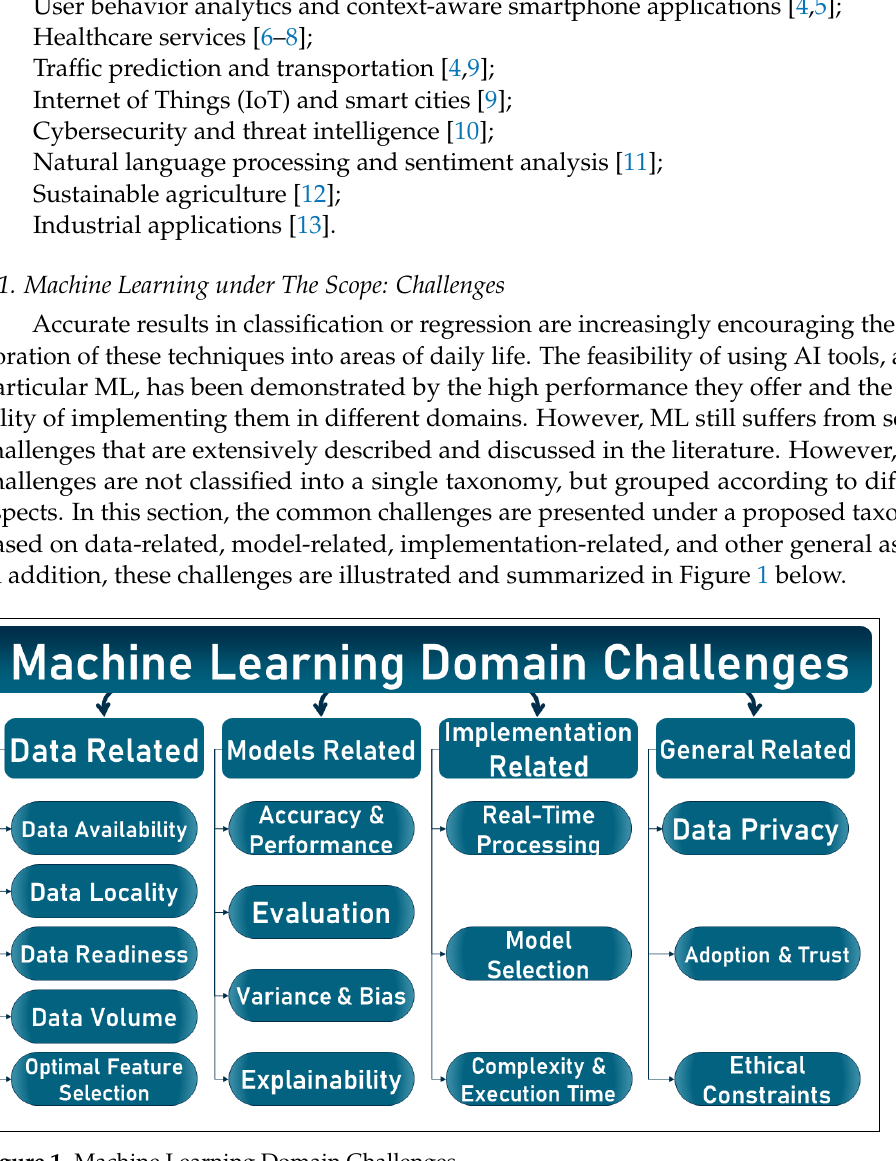
Figure 1. Machine Learning Domain